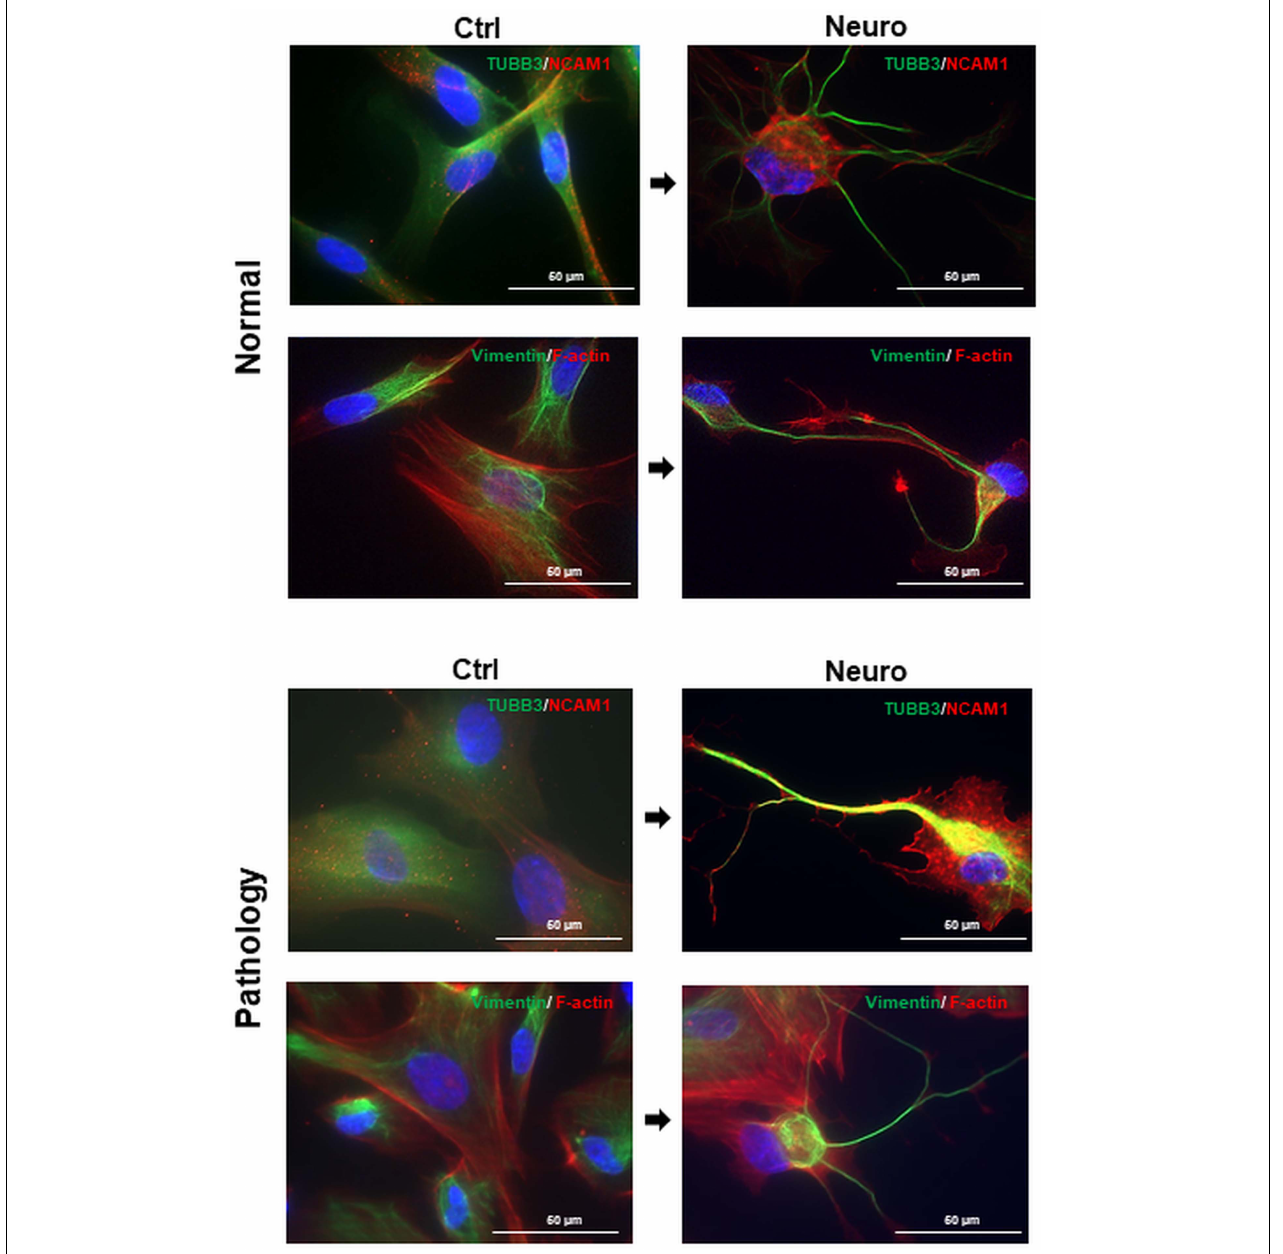
FIGURE 4 | Cytoskeletal reorganization and neural marker expression of control and neural differentiation-induced hAFSCs derived from normal and fetus-affected gestations. Representative images of healthy hAFSCs (Normal) and fetus-affected gestations (Pathology [Pat3]) shown. Neural differentiation was induced after 24-h exposure to pre-induction media, enriched with 20 ng/ml FGF and 20 ng/ml EGF, and further 3-h treatment with neuronal differentiation-inducing cell culture media, supplemented with 1 mM 8-Bromo-cAMP, 0.3 mM IBMX, 50 ng/ml BDNF, 100 ng/ml NGF, 5 mM KCl, and 2 µ M RA (see III protocol in section “Materials and Methods,” Table 1 ). Immunofluorescence analysis of hAFSCs showing positive cells for neural marker TUBB3 and cytoskeletal protein Vimentin (green) as well as neural marker NCAM1 and cytoskeletal protein F-actin (red). Nuclei were counterstained with DAPI (blue); scale bar = 50 µ